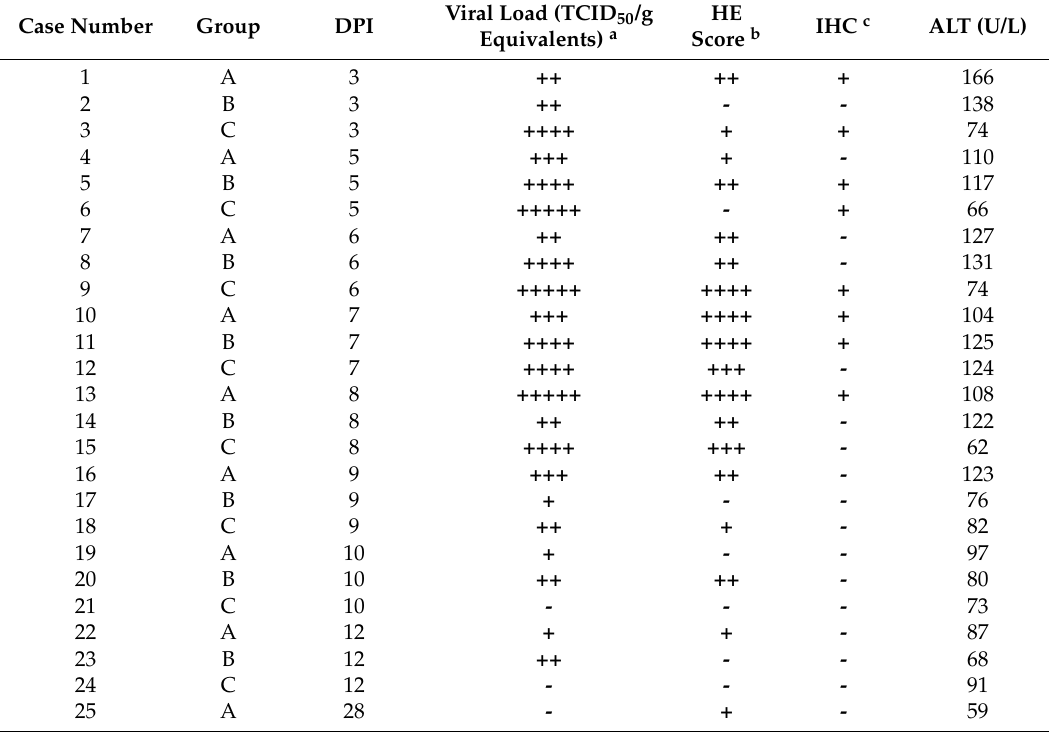
Figure 1. Scatterplots (symbols) and mean values (lines) of complete blood count and leukocyte differentials for Rousettus aegyptiacus bats experimentally inoculated with Marburg virus in a serial euthanasia study; black circles = inoculated bats; open diamonds = mock-inoculated control bats; solid line = mean cell count for inoculated bats; dashed line = mean cell count for mock-inoculated control bats. ( A ) Total white blood cell counts. ( B ) Lymphocyte counts. ( C ) Monocyte counts. ( D ) Granulocyte counts. Table 1. Liver viral load, liver histologic score, liver immunohistochemical staining results, and alanine aminotransferase (ALT) values for Egyptian rousette bats ( Rousettus aegyptiacus ) experimentally infected with Marburg virus in a serial euthanasia